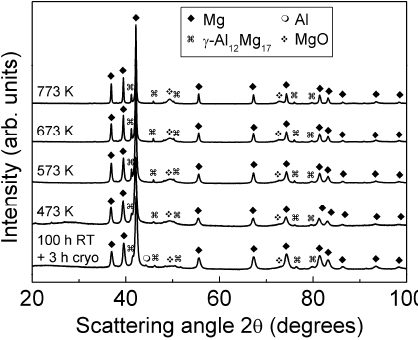
radiation) of the nanostructured Mg-7.4%Al Figure 7. XRD patterns (Co-K α powder milled at RT for 100 h followed by 3 h of cryo-milling after heating to different temperatures.